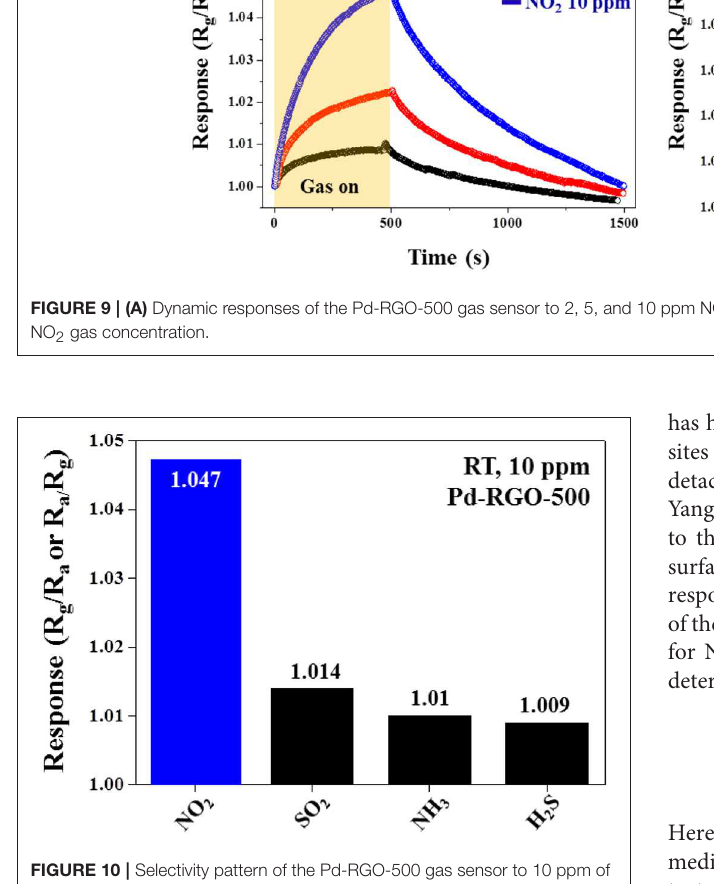
NO 2 gas, demonstrating the p-type behavior of the gas